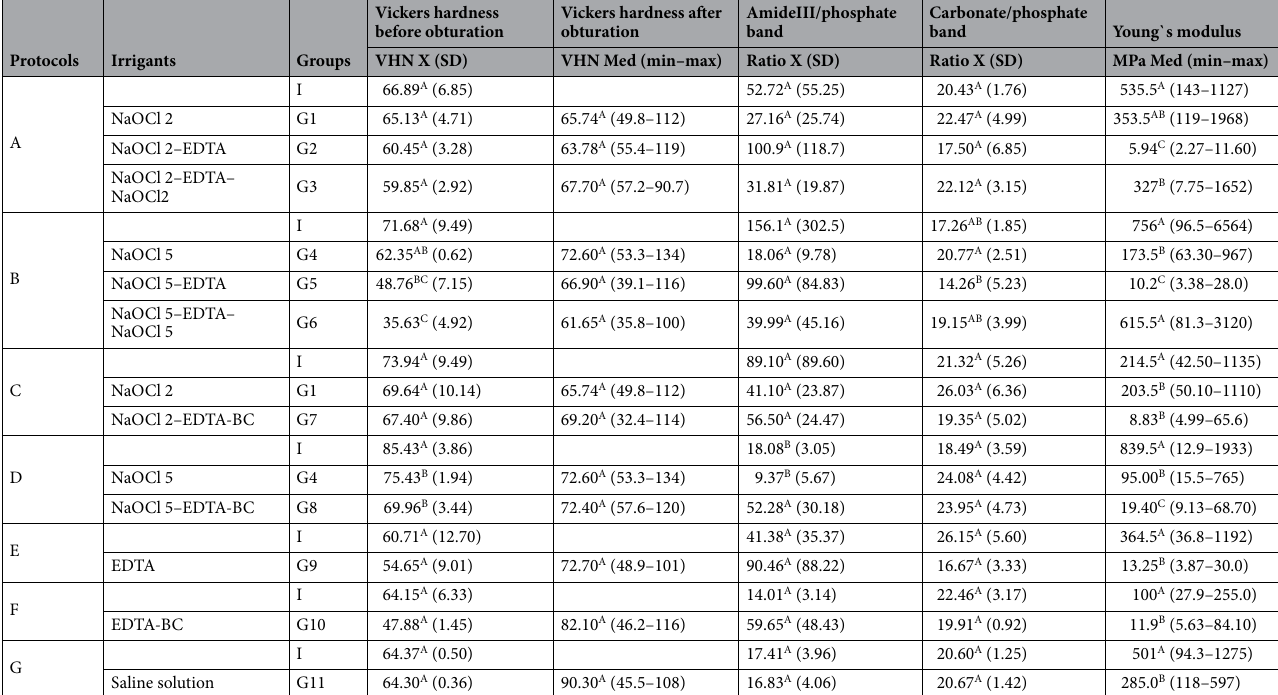
Table 2. Mean (X) and standard deviation (SD) values of Vickers hardness number (VHN), amide III/ phosphate and carbonate/phosphate bands of dentin surface before (initial—I) and after immersion in the irrigation solutions (G1–G11) as indicated in protocols A–G which are detailed in Table 1. Median (Med), Maximum (Max) and Minimum (Min) values of Young`s modulus of coated dentin surface as indicated before and it Vickers hardness number after